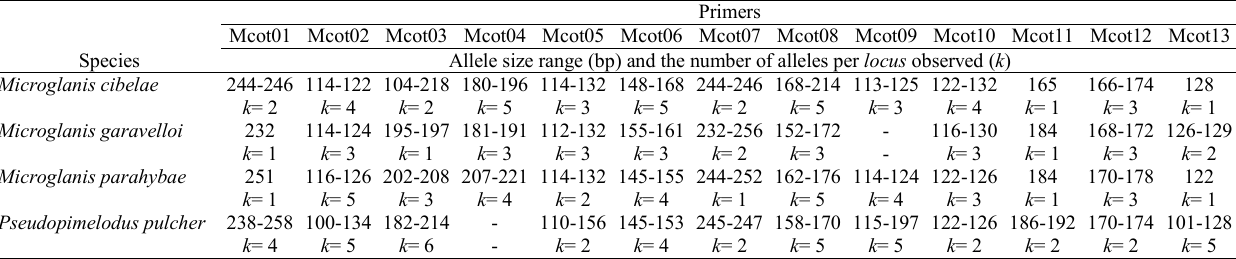
Table 2. Cross-amplification of 13 loci in four species of Pseudopimelodidae. Amplifications and polymorphisms were tested in five individuals of each species. - indicates no amplification. k = the number of alleles per locus